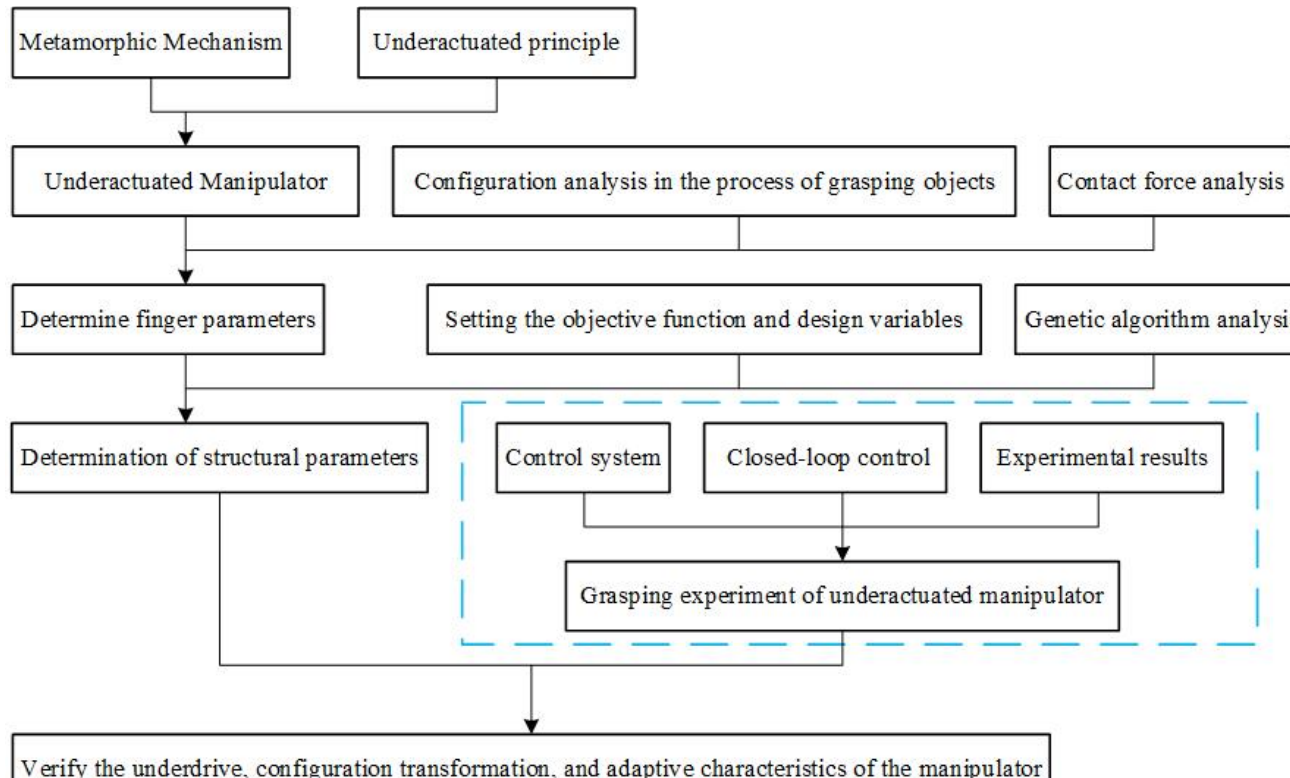
Figure 1. Flow diagram of the underactuated manipulator design method